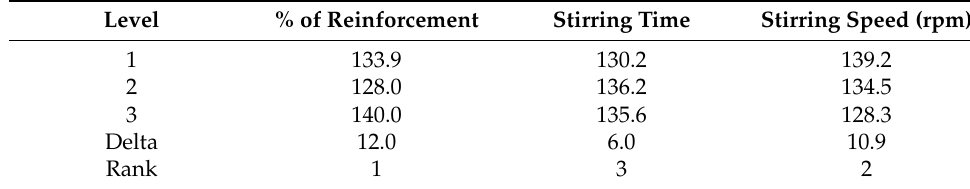
Table 11. Response table for means (wear).